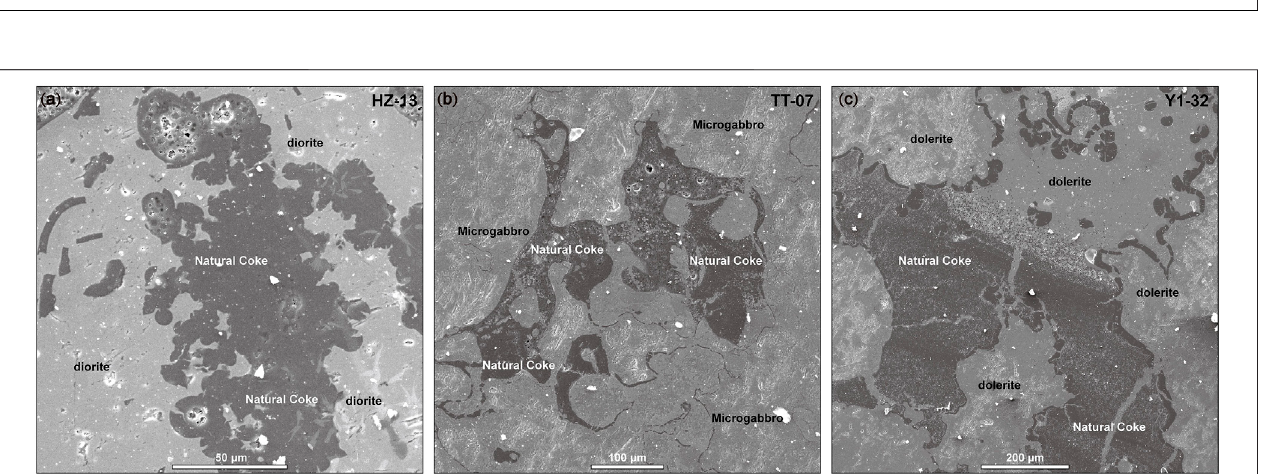
Frontiers in Earth Science |